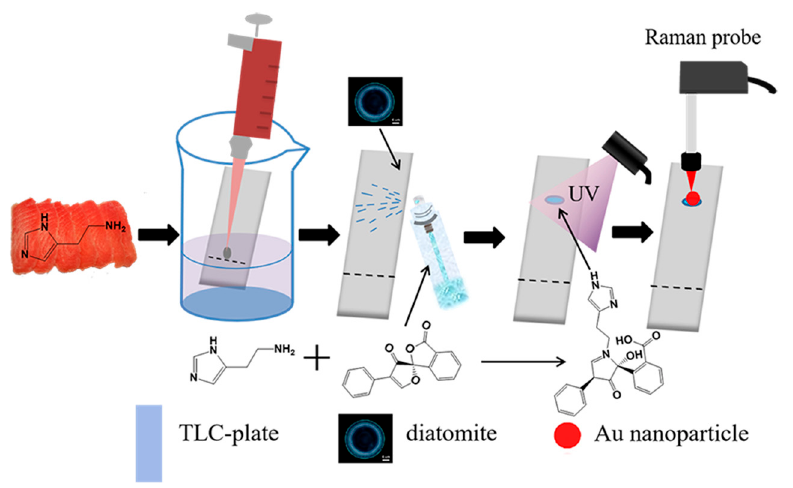
Figure 5. On-site derivatized-TLC-SERS for detecting histamine in tuna. Reprinted with permission from ref. [77]; Copyright 2022 Elsevier.